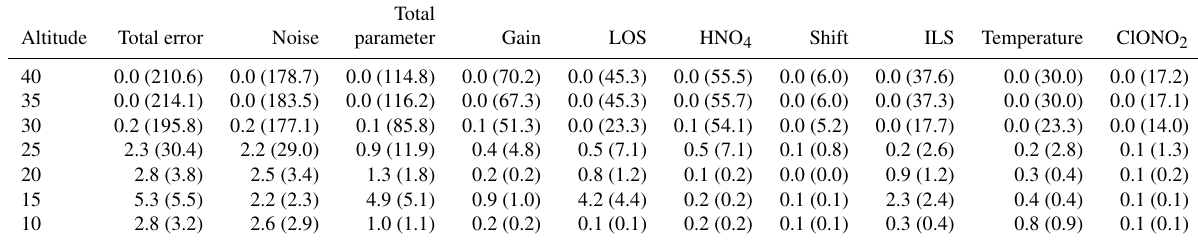
Table A1. Error estimates for an equatorial profile during the FR period. Errors are given in pptv (relative errors in %).